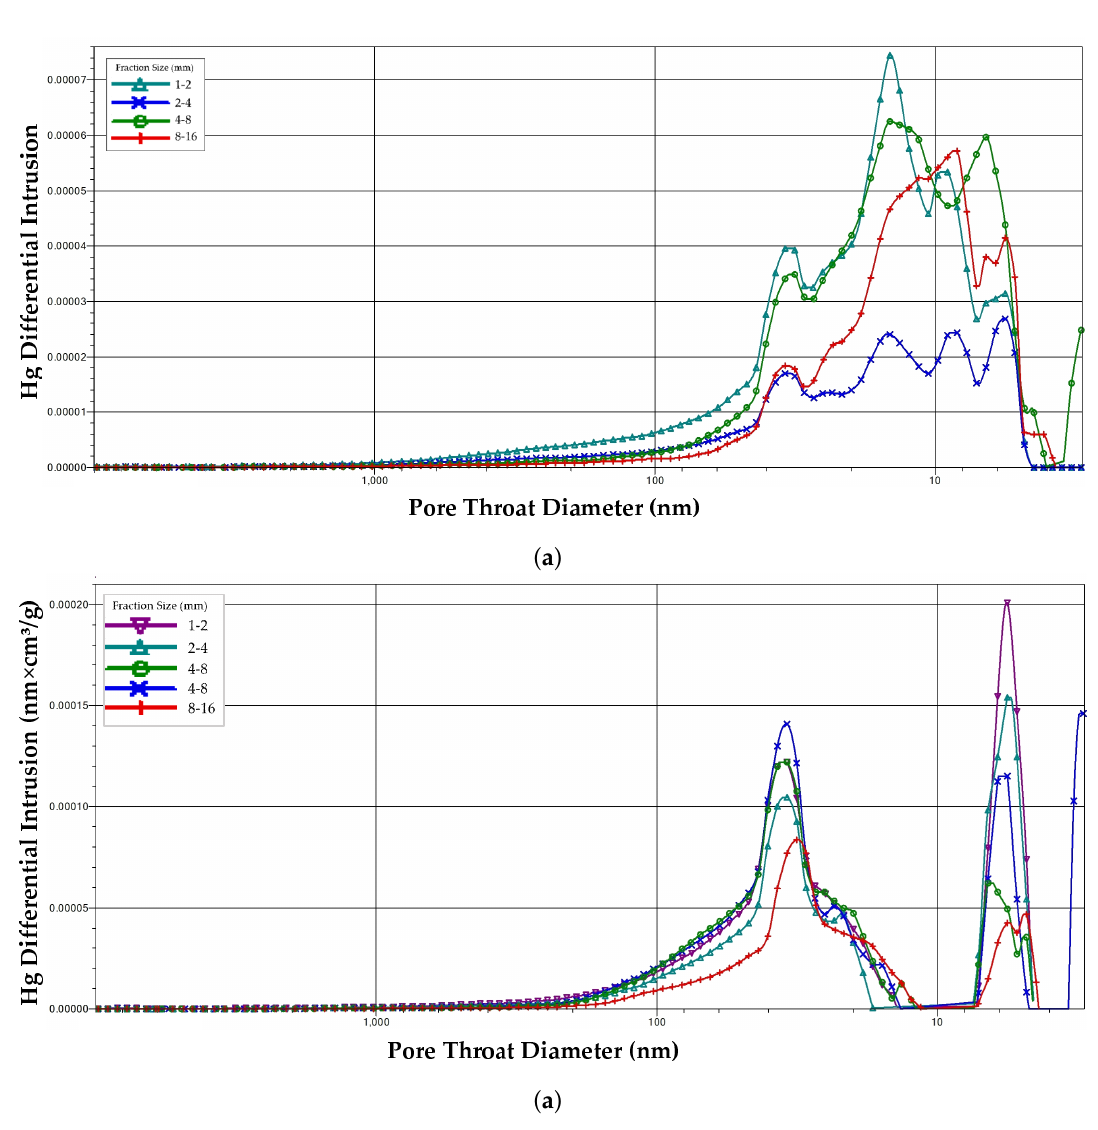
Figure13. MICPPSDsforthewholecore#551dependontherockfractionsizebeforeandafterextraction. For both samples, the pore throat size spanned in the range of 10–100 nm. The whole core